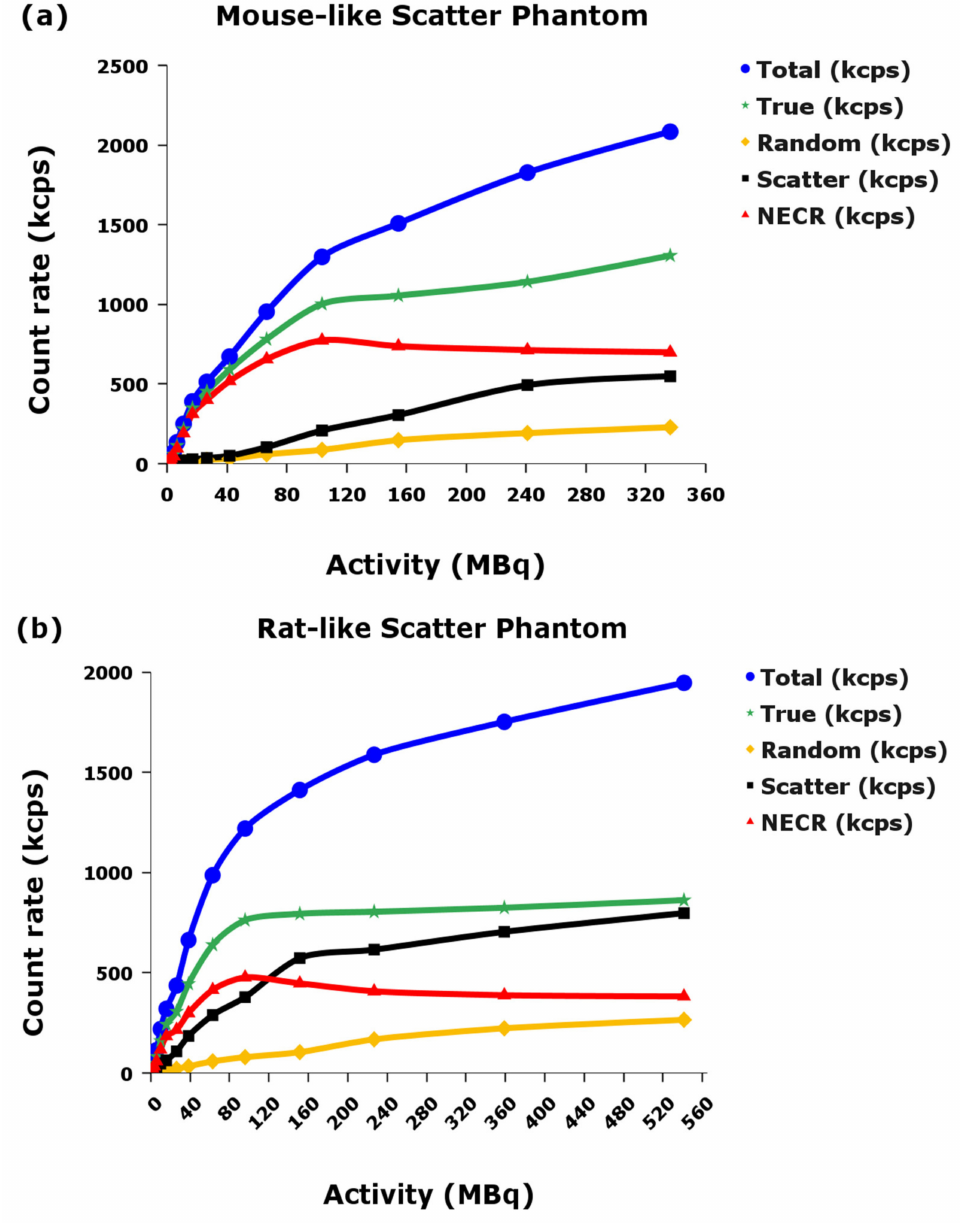
Figure 8. The system count rates, such as total, true, random, scatter, and NECR, as factors of activity (MBq). ( a ) Mouse-type scatter phantom. ( b ) Rat-type scatter